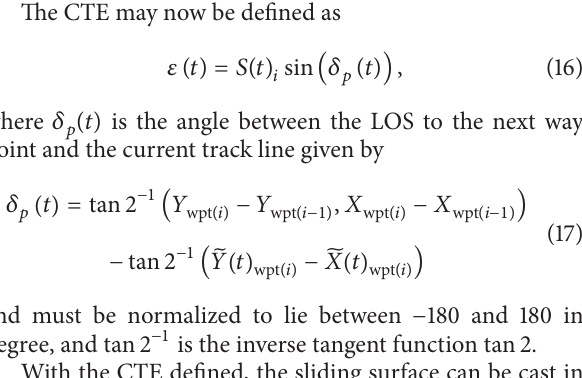
To avoid division by zero, in the rare case where cos ( ̃𝜓(𝑡)) = 0 , the rudder command is set to zero since this condition is transient in nature. In addition, a bound of 30 degrees is used as a switch to LOS control which